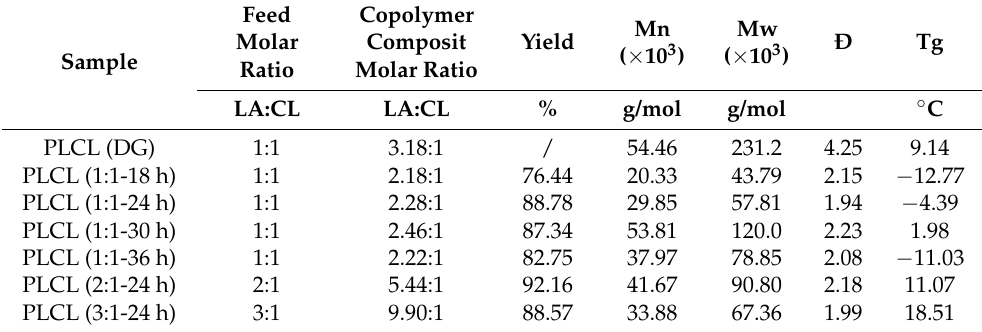
Table 1. Characterization of PLCL (DG) and PLCL copolymers synthesized at different